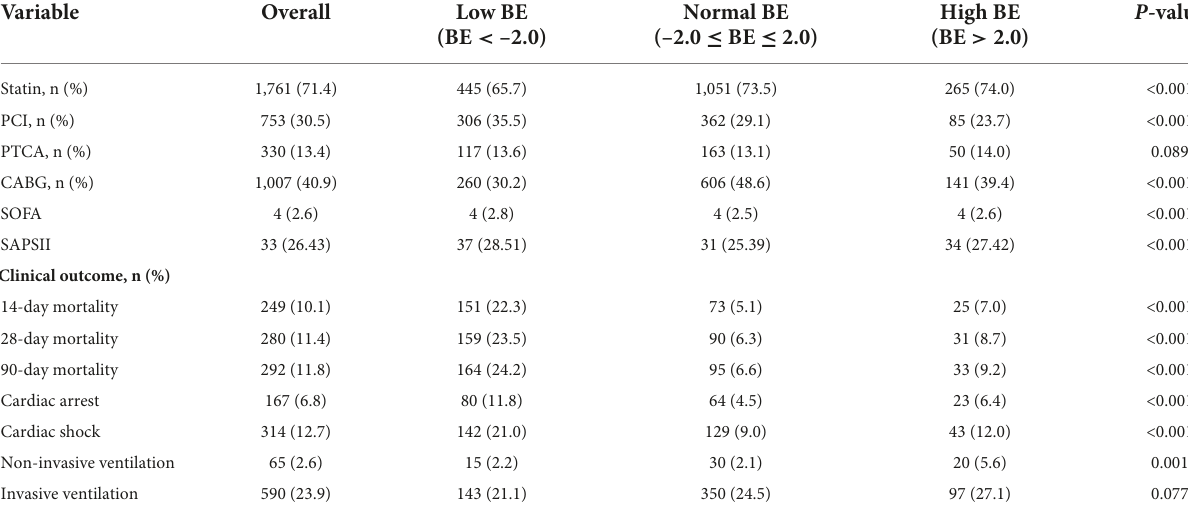
To further explore the relationship between the BE and mortality of AMI, an analysis of Kaplan-Meier data revealed that the low BE group had significantly higher 28-day mortality ( Figure 1 ) and 90-day mortality ( Supplementary Figure 1 ) compared with the normal and high BE groups. Based on admission BE estimates, the RCS corresponding to the risk of 28-day all-cause mortality showed an “L-type” relationship between BE and the risk of mortality ( Figure 2A ). After